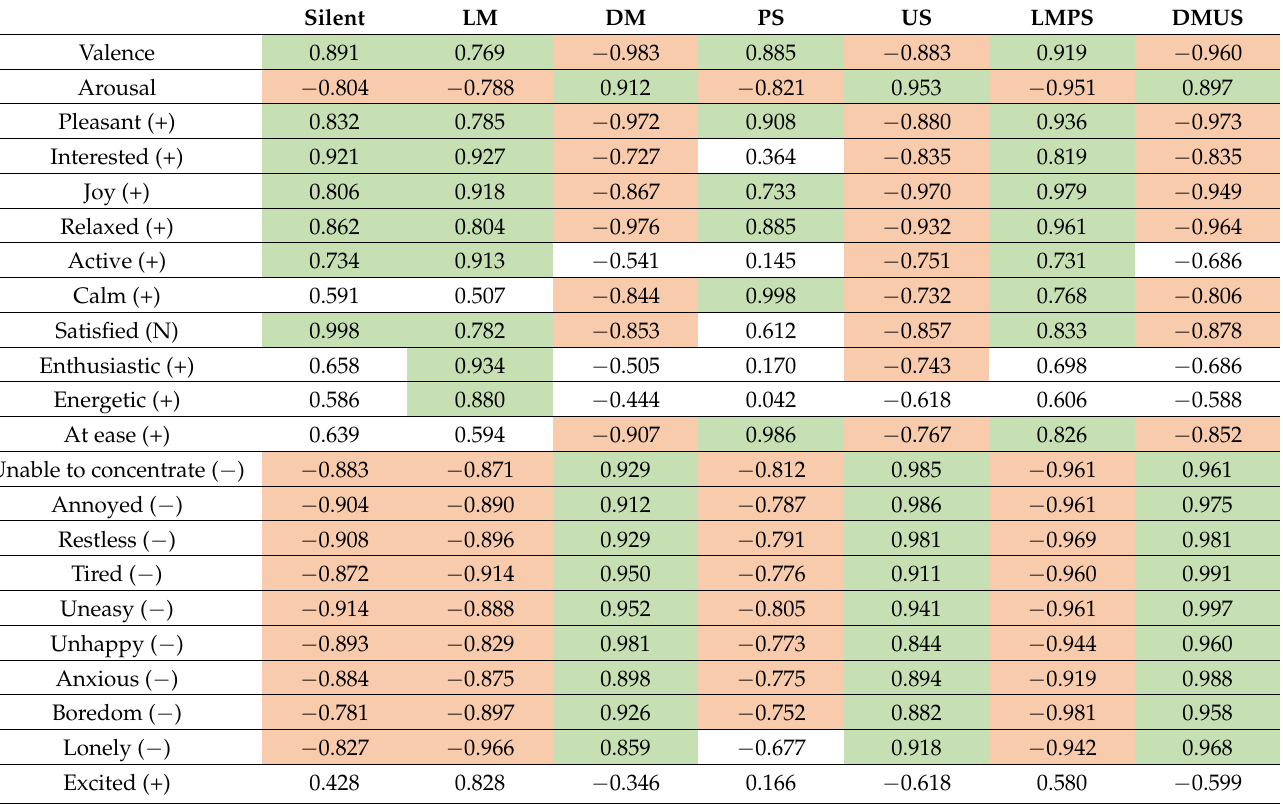
Table 2. Cosine values between music and sound conditions and the attributes used to describe the emotions, obtained by correspondence analysis (CA) for seven conditions using CATA terms. Values in green and orange indicate high positive and negative correlations respectively between the emotion attributes and ice cream samples consumed under different sound